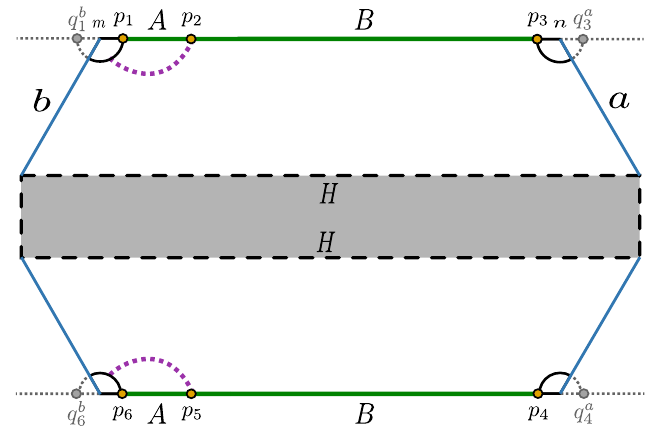
Figure 3 . Dominant channel for the S R . EWCS is denoted by the violet dotted curve. Here q b = r I − (cid:15) is the mirror image of the point p 1 = r I + (cid:15) with respect to the b -boundary at point 1 p I = r I . Similarly, q a = r O + (cid:15) is the mirror image of the point p 3 = r O − (cid:15) with respect to the a - 3 boundary at point p O = r O